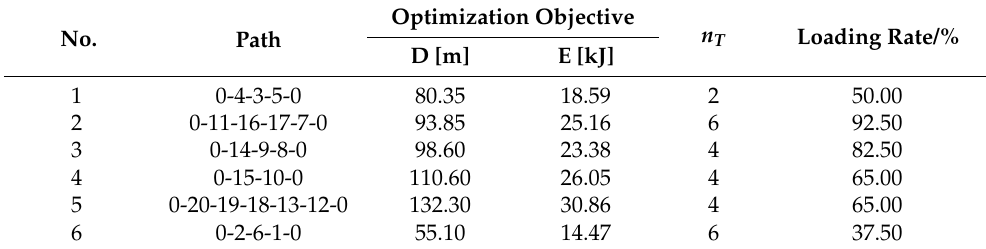
Table 11. Feasible paths for using type 2 AGV fleet transportation. No.